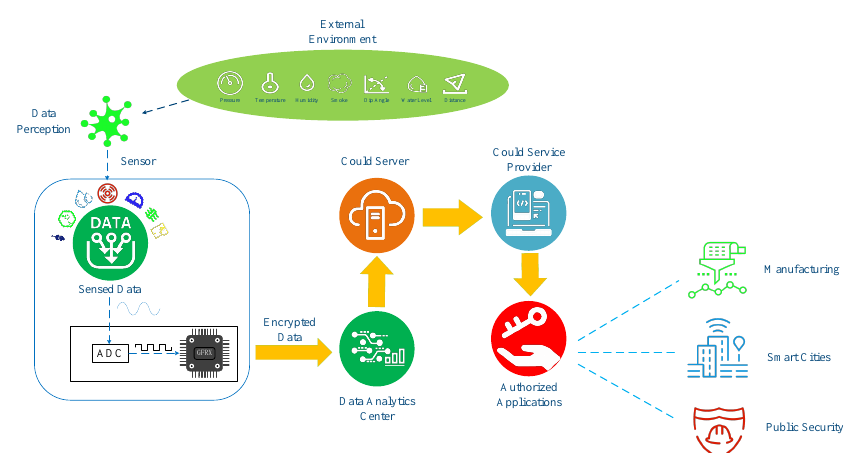
Figure 1. The process of sensor information